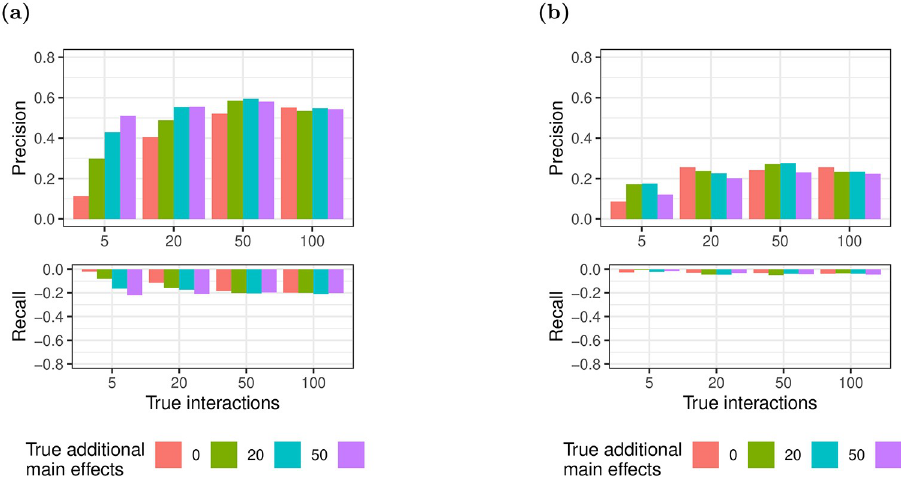
Fig 2. Trade-off between precision and recall for selecting the subset of interactions significantly deviating from zero versus all interactions. Top and bottom panels depict gain of precision and loss of recall, respectively. (a) glinternet ; (b) xyz